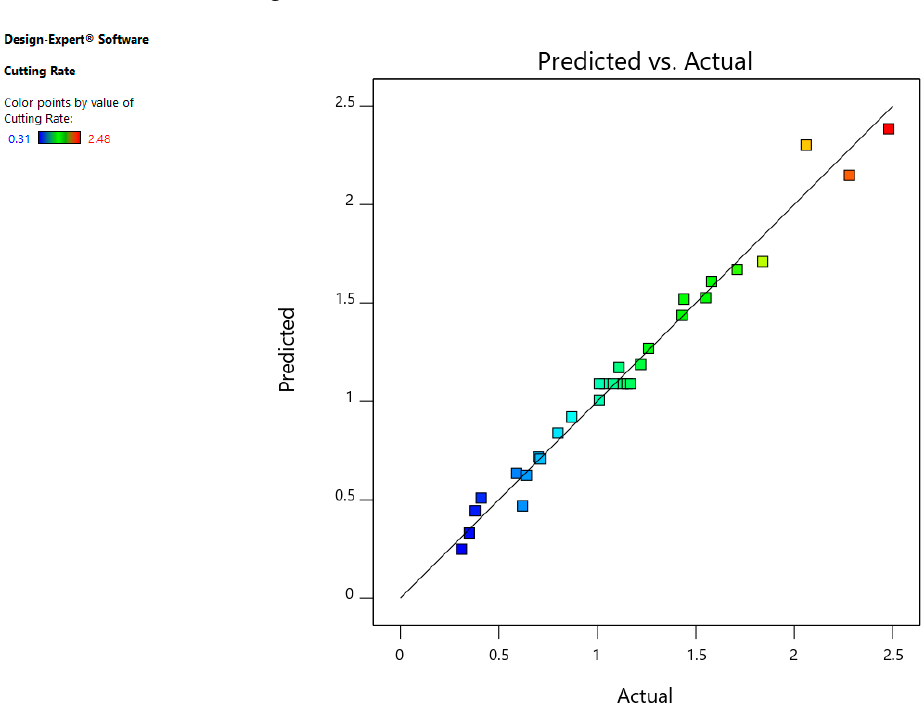
Figure 5. Predicted versus actual plot for CR.